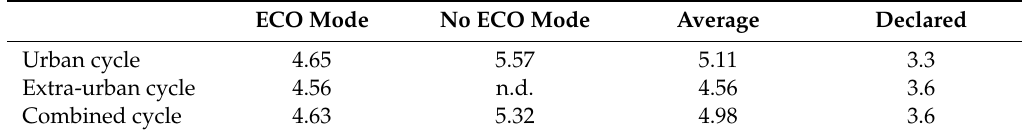
Table 21. Fuel consumption for considered HV.